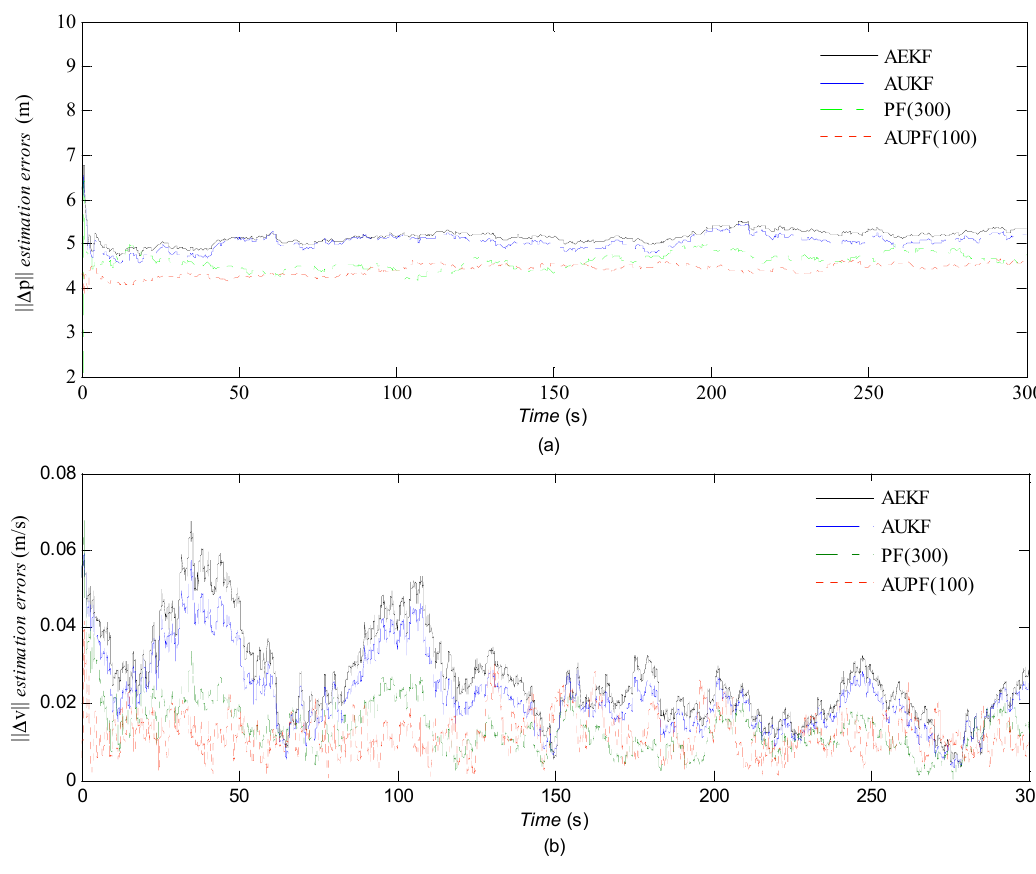
Figure 8. ( a ) Norm of position estimation errors; ( b ) Norm of velocity estimation errors.